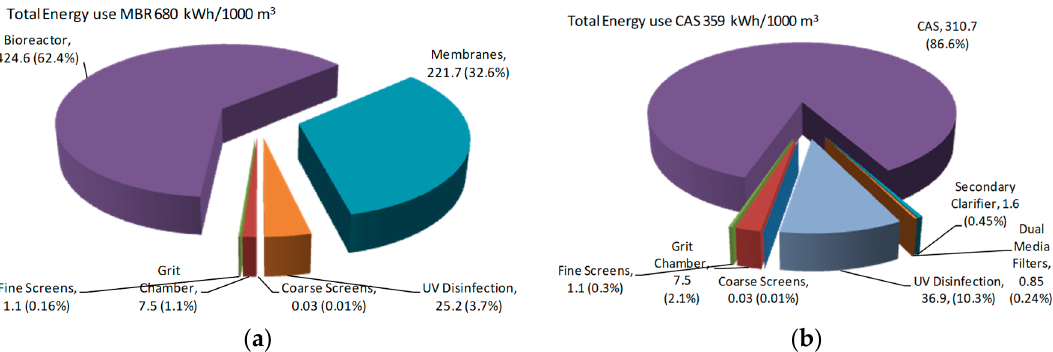
Figure 3. Energy consumption and percentage share of all unit processes in water reuse plants (WRPs): ( a ) MBR; ( b ) CAS.